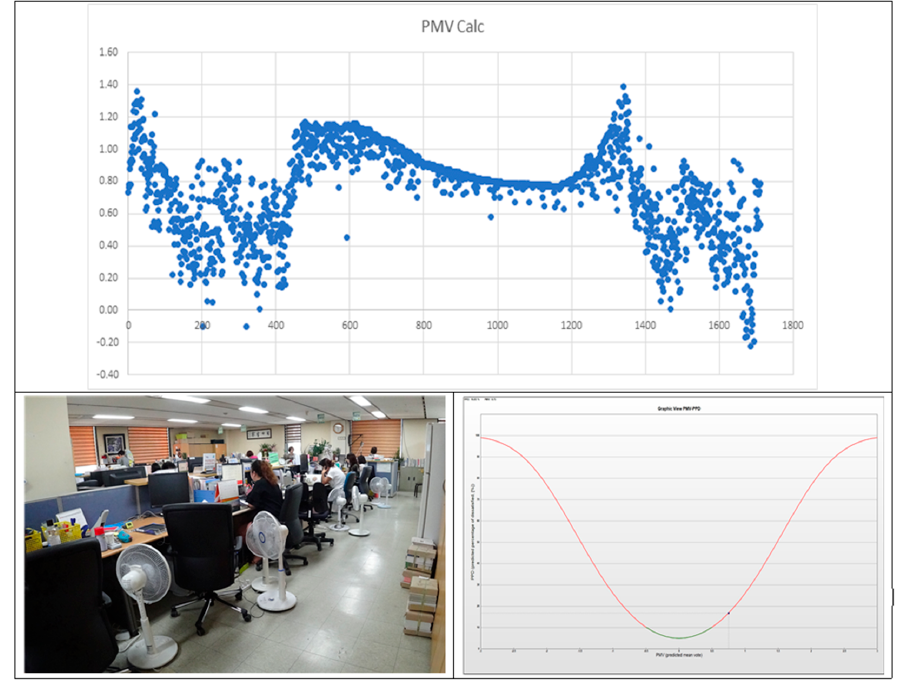
Figure 8. PMV in the energy saving environment in a public institution building against a black- out.